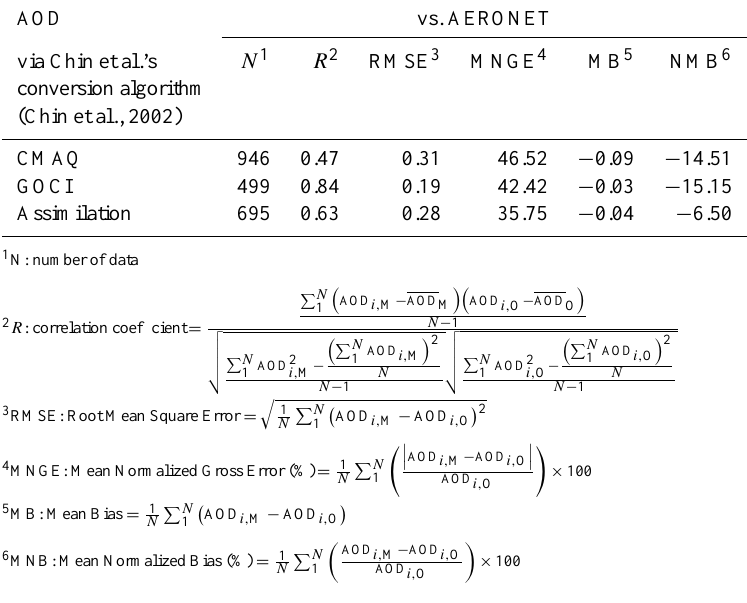
Table 5. Statistical analysis among AERONET, GOCI-retrieved, CMAQ-simulated, and assimilated AODs for the modeling period of 1 April to 31 May 2011.